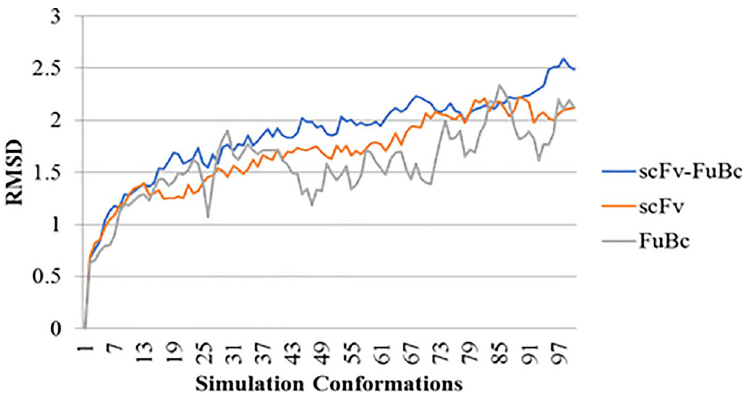
Fig 12. Simulation analysis of scFv FuBc interaction. RMSD value for scFv–FuBc interaction was higher than that of the individual proteins.